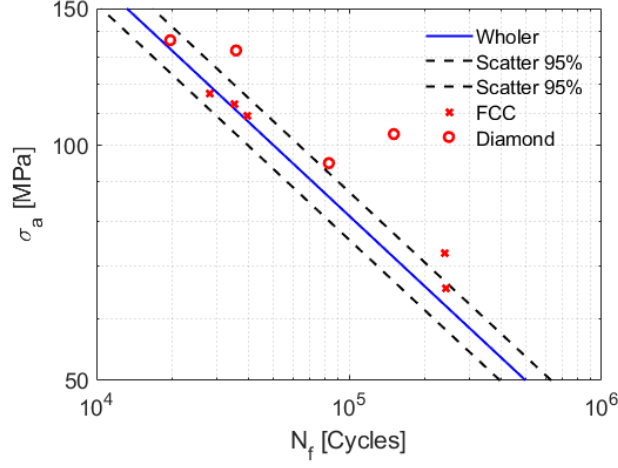
Figure 10. SN curve of the AlSi10Mg bulk material with superimposed SN data points associated to the FCC and Diamond configuration for resonant condition tests.